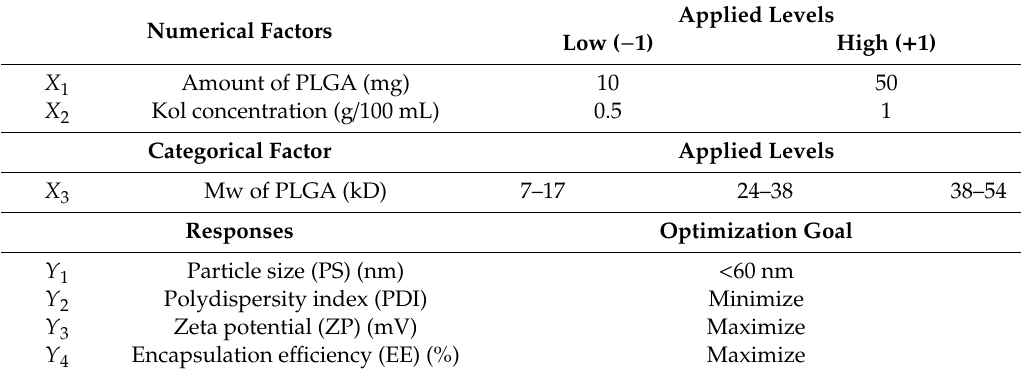
Table 1. Independent variables (factors) and dependent variables (responses) for the optimization of